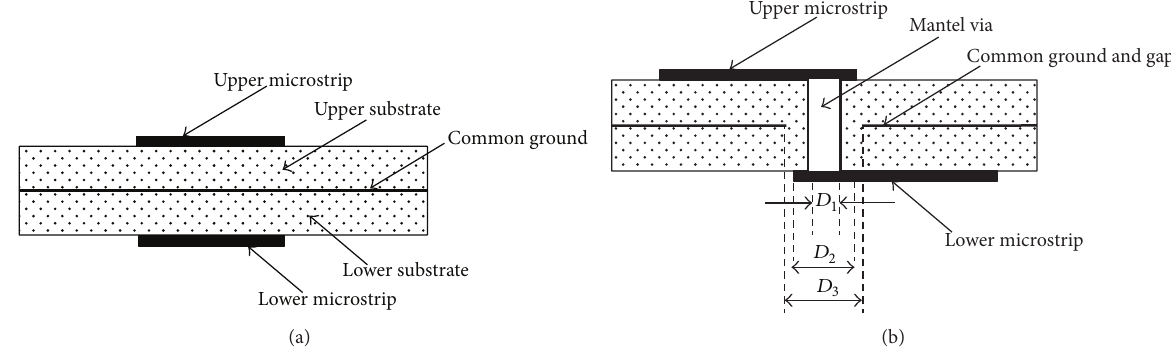
Figure 2: Schematic diagram of the bilayer microstrip section (a) and the schematic diagram of the via section (b).